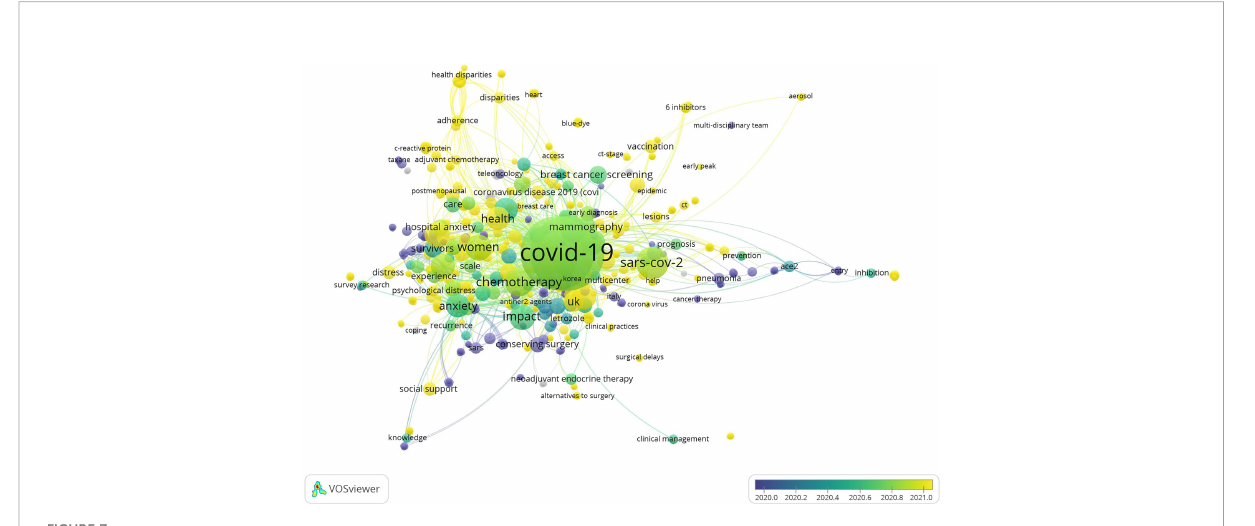
FIGURE 7 The co-occurrence map of keywords.